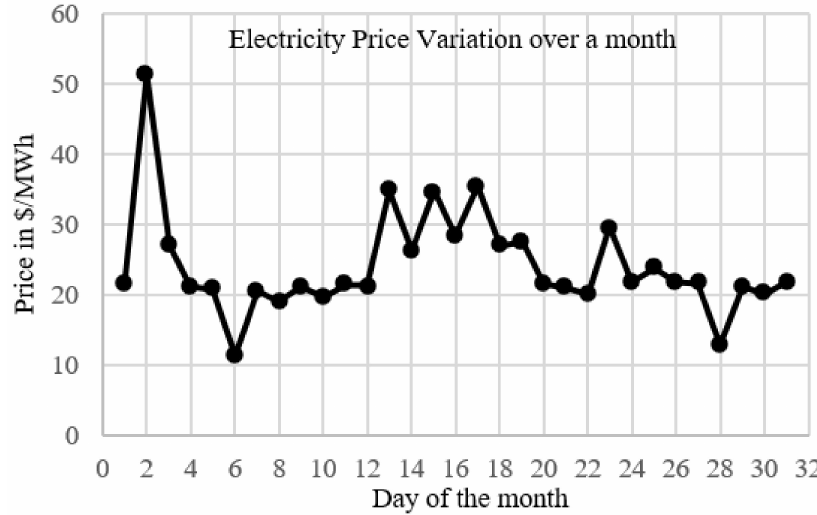
Figure 4. Variation of settlement point price over a month.